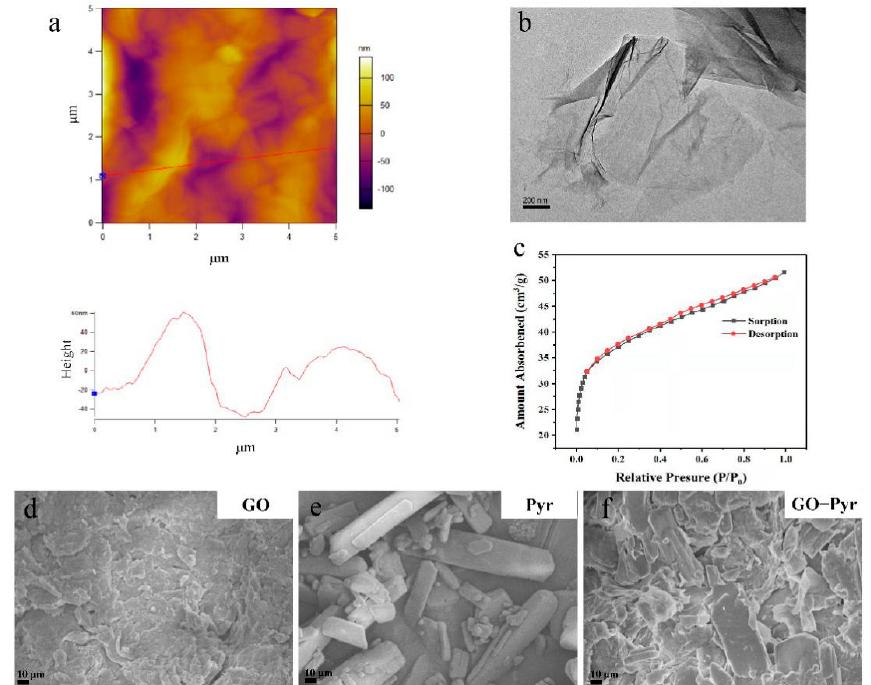
Figure 1. Morphological characterization of GO and formulated GO–Pyr nanocomposite. AFM images of GO ( a ), TEM images of GO ( b ), BET specific surface area of GO ( c ), SEM images of GO ( d ), Pyr ( e ), and GO–Pyr ( f ) at a mass ratio of 1:1. 3.2. FT-IR Characterization of Graphene Oxide–pyraclostrobin nanocomposite FT-IR spectra of GO, Pyr and GO–Pyr are shown in Figure 2. For GO, the peak at 3405 cm − 1 belonged to the O-H stretching vibrations, the vibrations of graphite skeleton were located at 1628 cm − 1 , peaks at 1720 and 1065 cm − 1 were contributed to COOH stretch- ing vibrations and C-O stretching vibrations. In the FT-IR spectra for Pyr, stretching vi- bration of benzene skeleton was found at 1548 and 1480 cm − 1 , and the carbonyl stretching vibration of the ester group was observed at 1716 cm − 1 [41,42]. Evidently, the spectra of GO–Pyr included all characteristic peaks of both GO and Pyr without a new peak, indi- cating physical loading of Pyr onto GO, which did not alter its chemical properties [43]. Figure 2. FT–IR spectra of GO, Pyr and GO–Pyr.